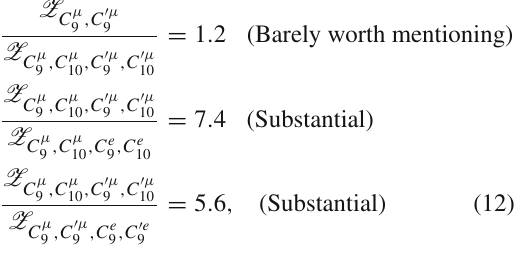
Fig. 3 a In green, the 1 σ (dark) and 2 σ (light) credible regions of the posterior pdf for the scan in the input parameters C Table 2), compared with the marginalized 2-dimensional regions in the same parameters for the scan with C row of Table 2), which are shown in brown ( 1 σ) and orange ( 2 σ) . The